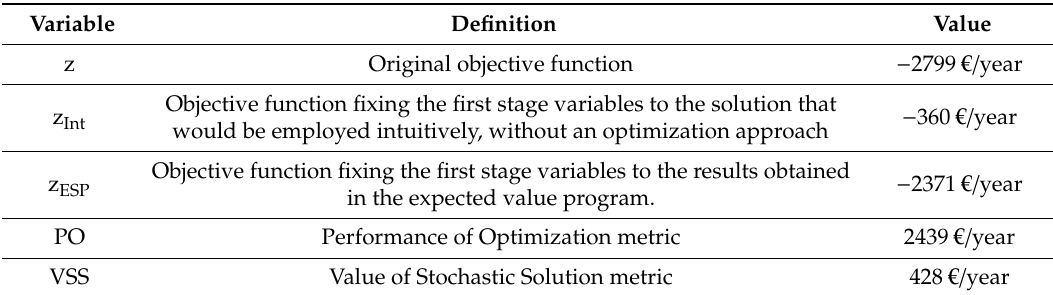
Table 15. Quality metrics definition and